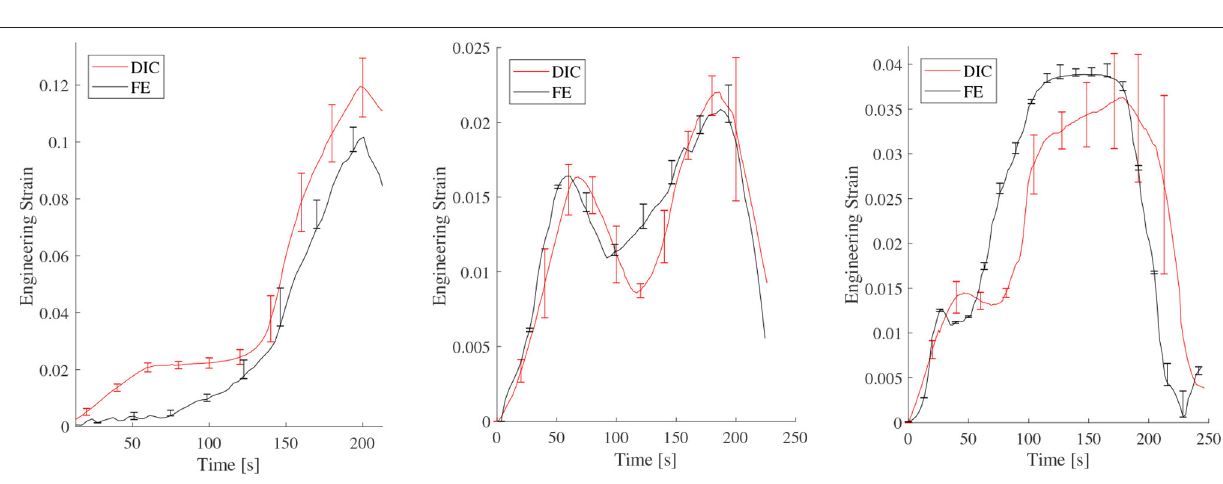
Frontiers in Materials |